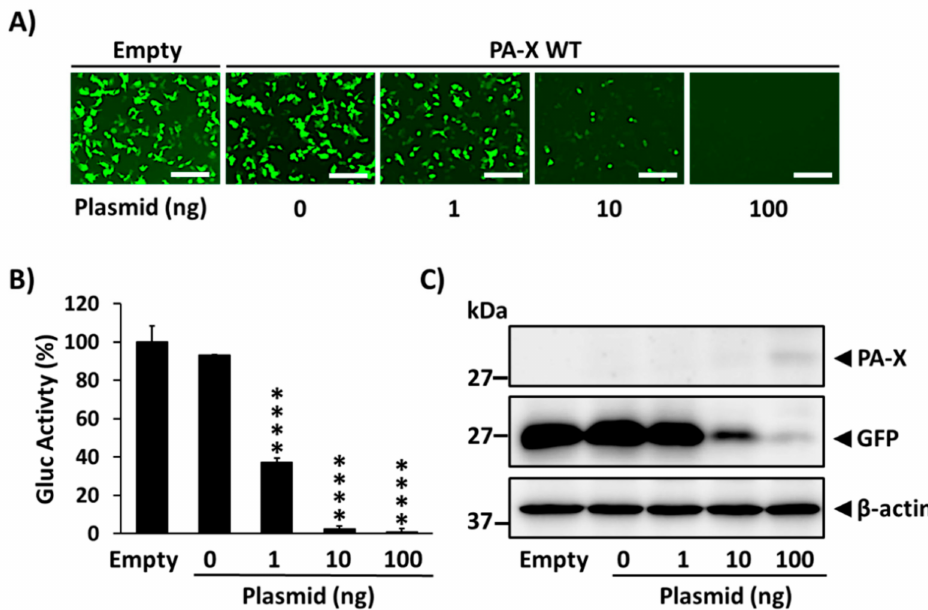
Figure 1. Ability of 1918 PA-X to inhibit host gene expression: HEK293T cells were co-transfected with increasing concentrations (0, 1, 10, or 100 ng/well) of a pCAGGS expression plasmid encoding wild-type 1918 PA-X (PA-X wild-type, WT) fused to an HA epitope tag, and 250 ng of pCAGGS-Gluc and -GFP plasmids. Empty plasmid transfected cells were included as controls. At 24 h p.t., GFP was observed under a fluorescence microscope ( A ), and Gluc activity was quantified using a GloMax system from cell culture supernatants ( B ). Gluc activity was normalized to empty plasmid transfected cells (100%). **** p < 0.0001; (0 ng of PA-X WT plasmid versus other concentrations) using one-way ANOVA and Dunnett’s test for multiple comparison correction. The presence of PA-X and GFP in cell lysates was analyzed by Western blot using anti-HA or anti-GFP PAbs, respectively ( C ). β -actin was used as a loading control. Results are the means and SDs of triplicates. Data are representative of three separate experiments. Magnification 20 × , scale bar, 100 µ